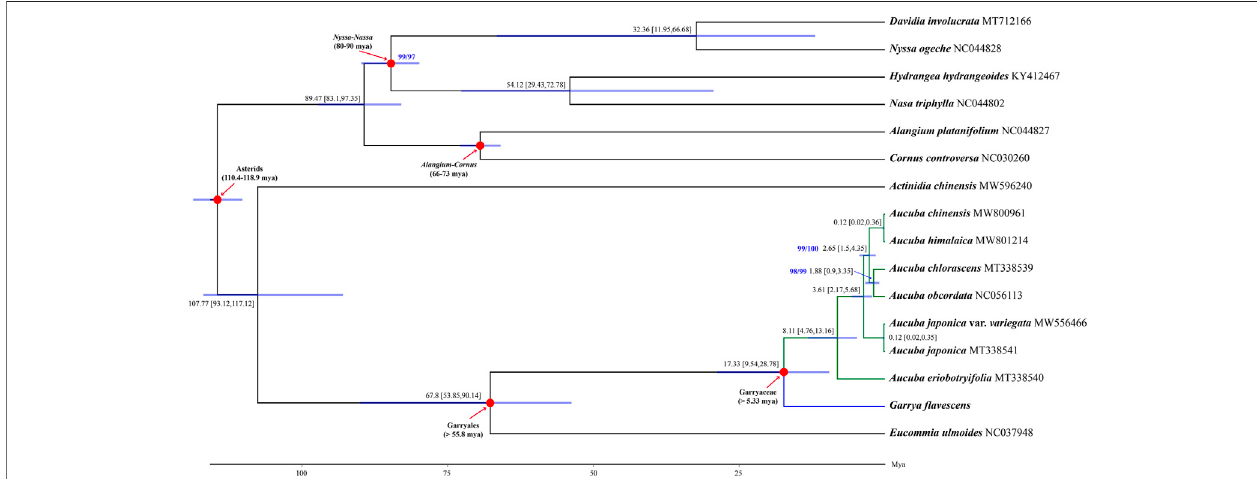
FIGURE 3 | A chronogram based on 68 plastid CDSs of 16 asterids illustrating divergence times of Aucuba . Mean divergence times and their 95% posterior probability intervals are shown near each node. The blue bars at the nodes indicate 95% posterior probability intervals. Numbers highlighted in blue near the clades are supportvaluesreportedasSH-aLRT(%)/UFBoot(%),andonlyvaluesthatarenot100/100 areshown.TheGenBankaccessionnumberforeachtaxonwasfollowedby taxa name. Red arrows show thecalibratingcladesfor molecular dating, timeused for calibratingare also shown. Divergence time and the timeline are indicated in million years ago